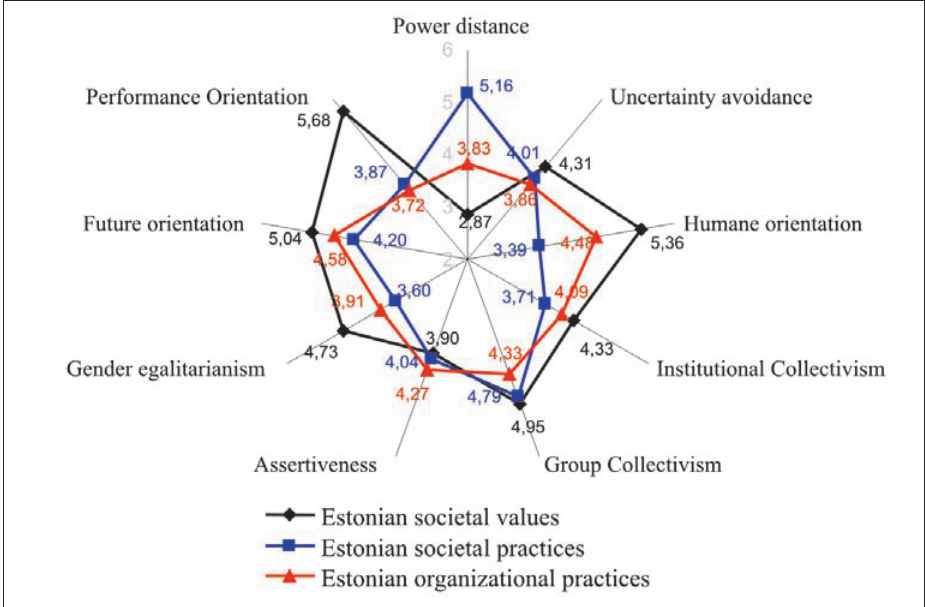
Fig 3 . Societal values and societal and organizational practices in Estonia